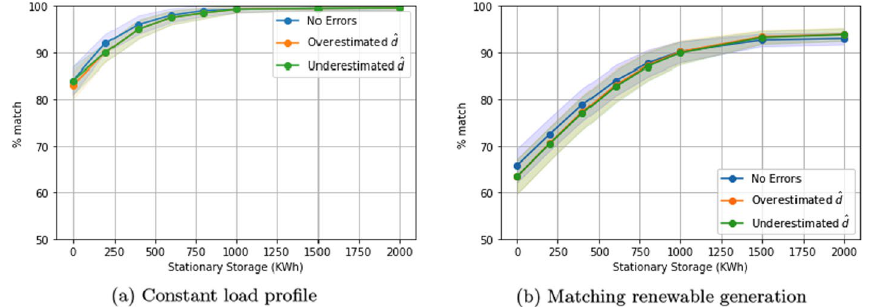
Fig. 11 Impact of errors in estimating duration. Errors of up to 25% in charging duration estimation do not significantly affect performance. One-way charging in a residential